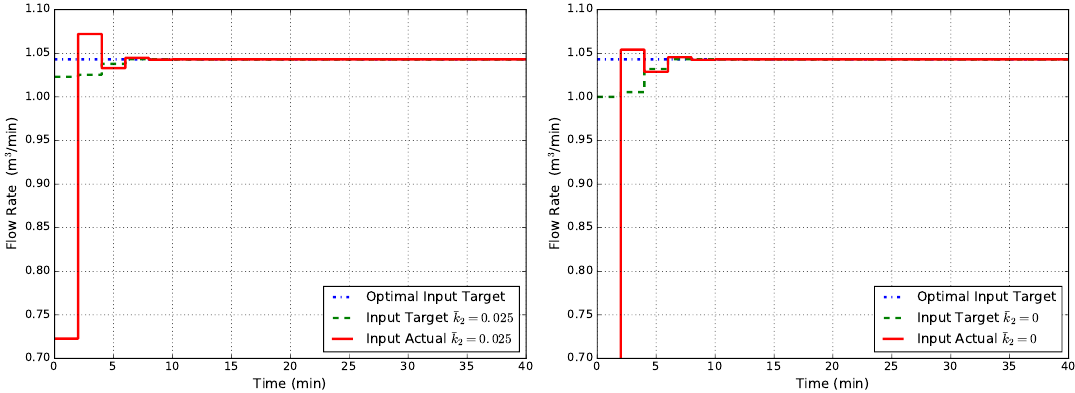
Figure 4. Closed-loop flow rate Q obtained with EMPC2 (non-linear state disturbance model) for two cases of uncertainty in k 2 : ¯ k 2 = 0.025 ( left ) and ¯ k 2 = 0 ( right